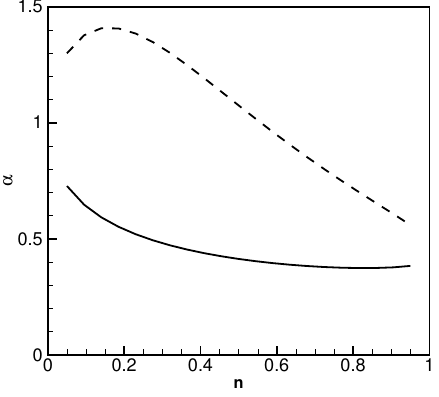
Figure 3. Two α roots for different n values.